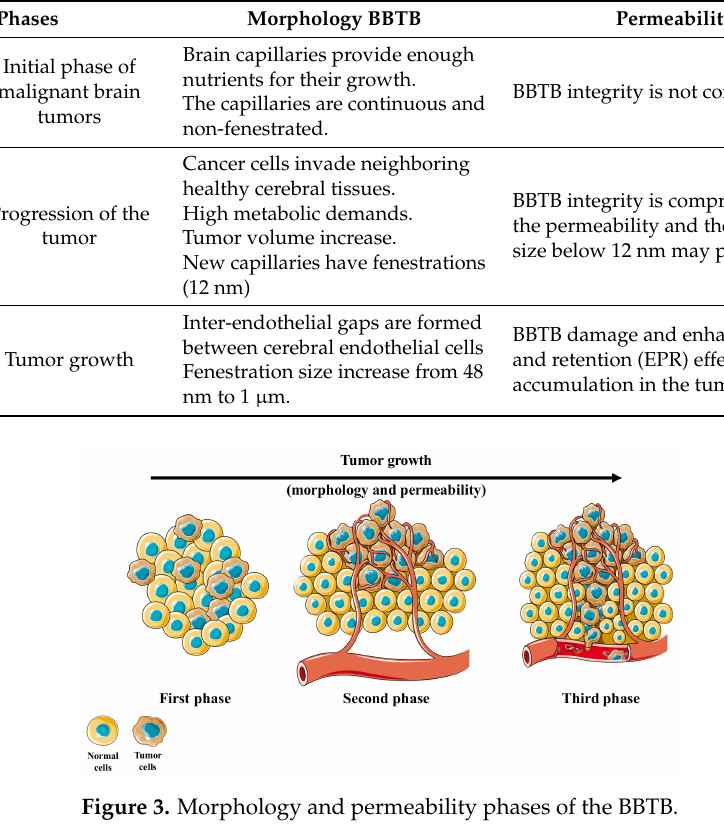
Table 4. Description of the morphology and permeability phases of the blood–brain–tumor barrier (BBTB).